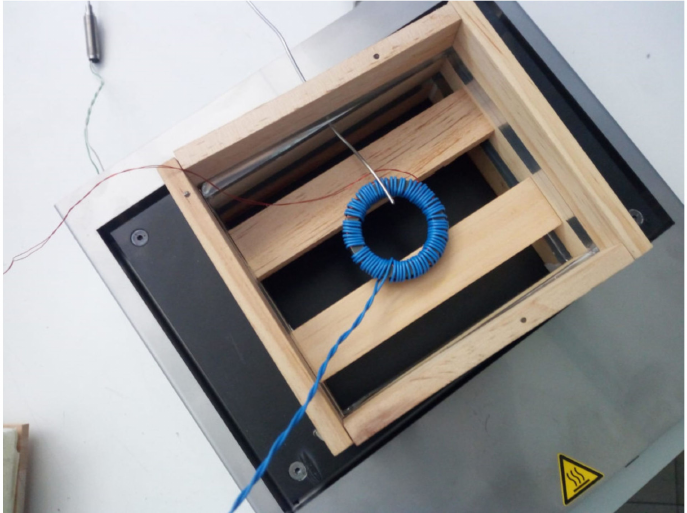
Figure 1. The toroid Soft Magnetic Composite (SMC) samples inside the implemented chamber (without cover).